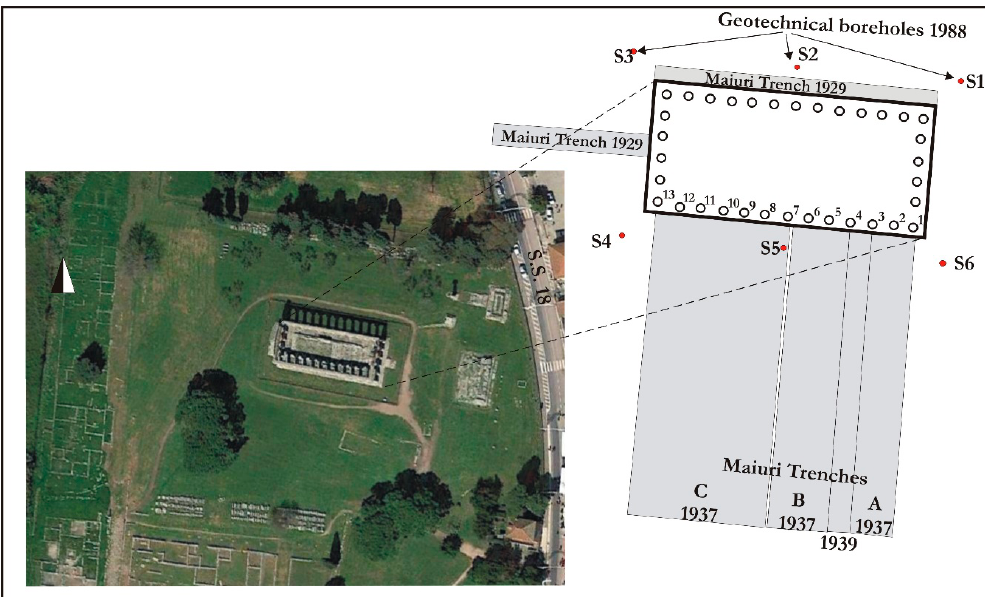
Figure 2. Location of archaeological trenches and boreholes dug during the last century around the Temple of Athena, superimposed on a GoogleEarth TM satellite image.